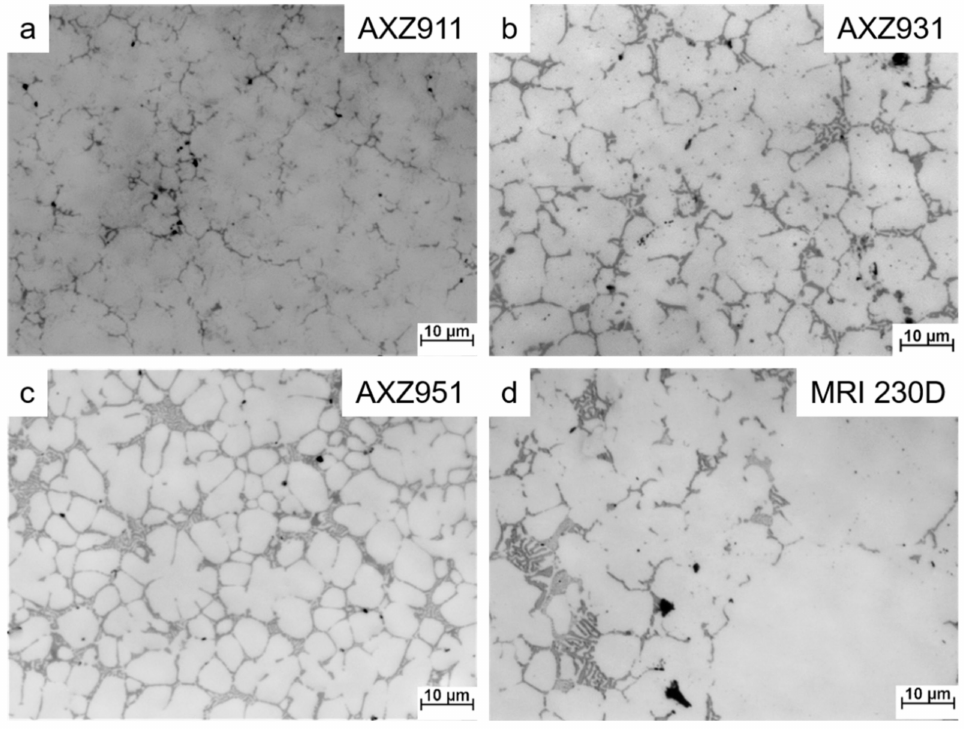
Figure 1. Light microscopy images of the investigated alloys in as-cast condition; ( a ) AXZ911,